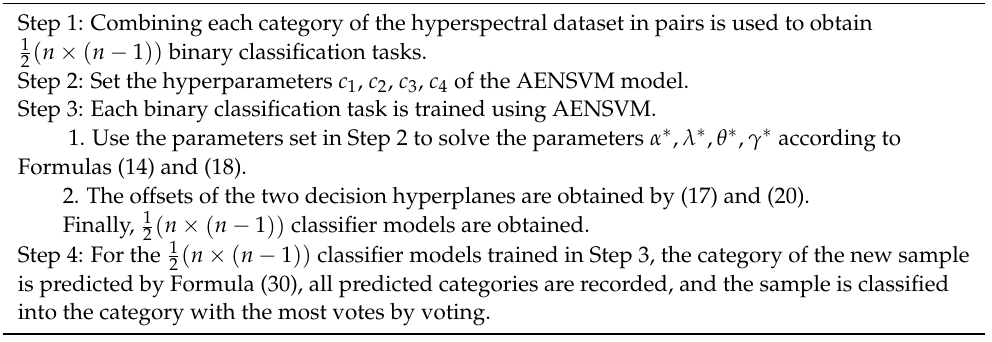
Algorithm 1. The classification process of the AENSVM algorithm model on the hyperspectral